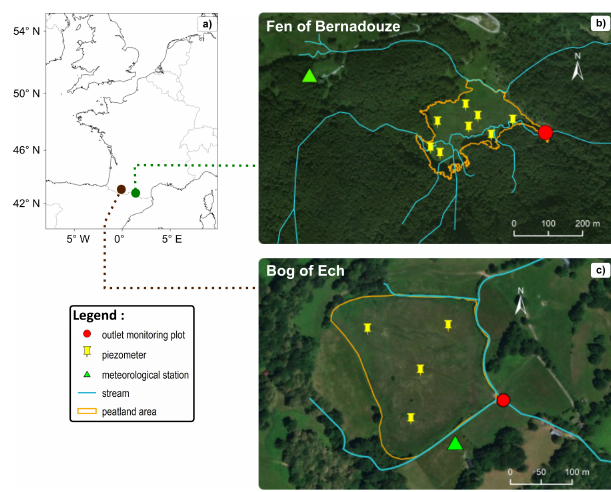
Figure 1. (a) Location map of the Ech bog (brown plot) and Bernadouze fen (green plot) in southwestern Europe. Satellite views of the peatlands of (b) Bernadouze (1343ma.s.l.) and (c) Ech (706ma.s.l.) and location of the site instrumentation. Map source: Esri, DigitalGlobe, Geoeye, Earthstar Geographics, CNES/Airbus DS, USDA, USGS, AEX, Getmapping, Aerogrid, IGN, IGP, swis- stopo and the GIS user